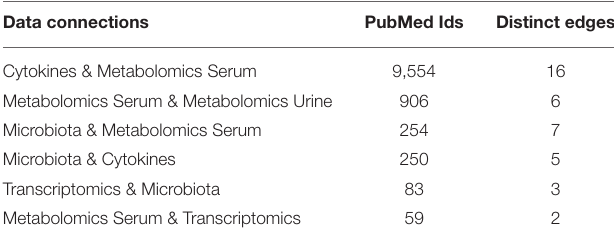
TABLE 4 | Overview of text mining